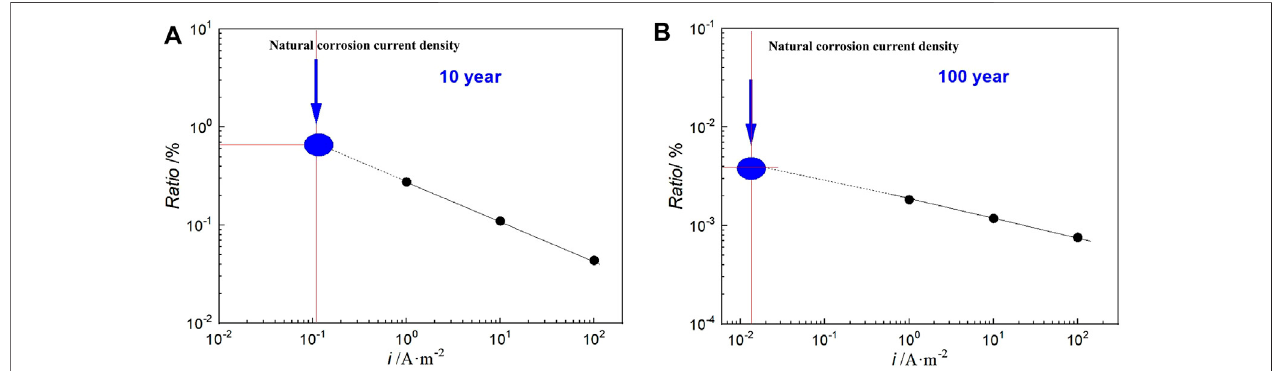
FIGURE 11 | Hydrogen permeation ef fi ciency of Q235 steel in highly compacted bentonite with hydrogen charging density; (A) 10 years; (B) 100 years.